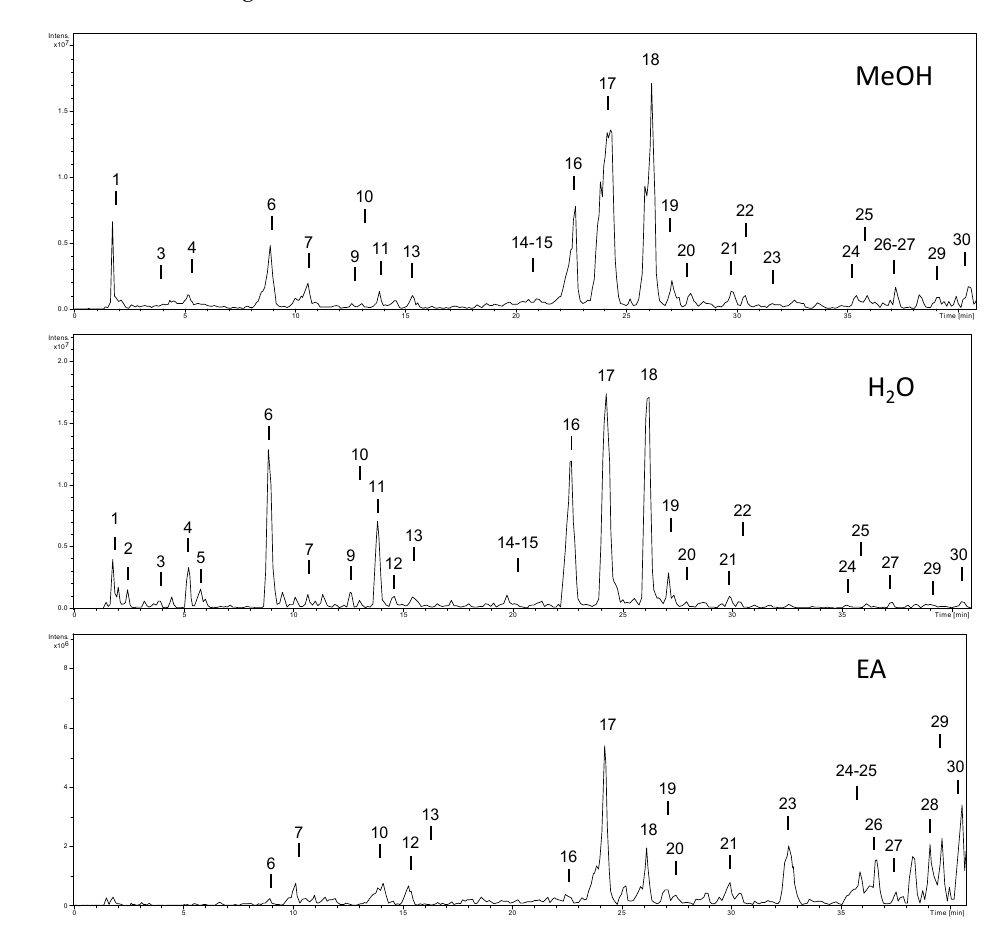
Figure 1. Base peak chromatograms of the extracts of Artemisia verlotiorum .